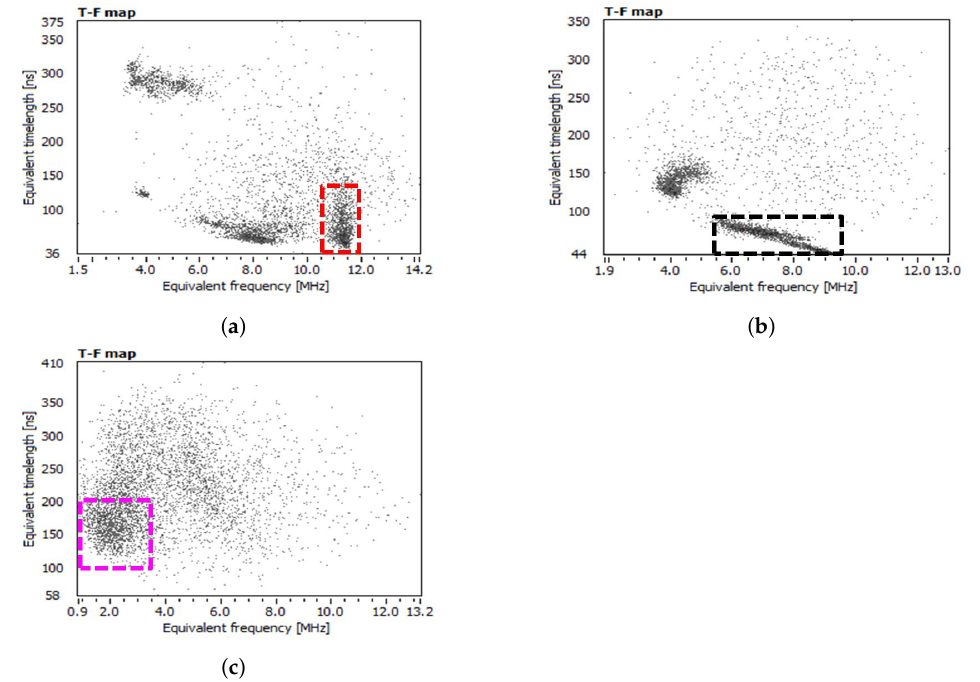
Figure 4. TF map clusters obtained during negative DC IPT. ( a ) Mobile discharge pulses form cluster having greatest W 2 coordinates. ( b ) Localized discharge pulses form cluster with mid-range W 2 coordinates. ( c ) High temperature discharge pulses form a cluster with lowest W 2 coordinates.